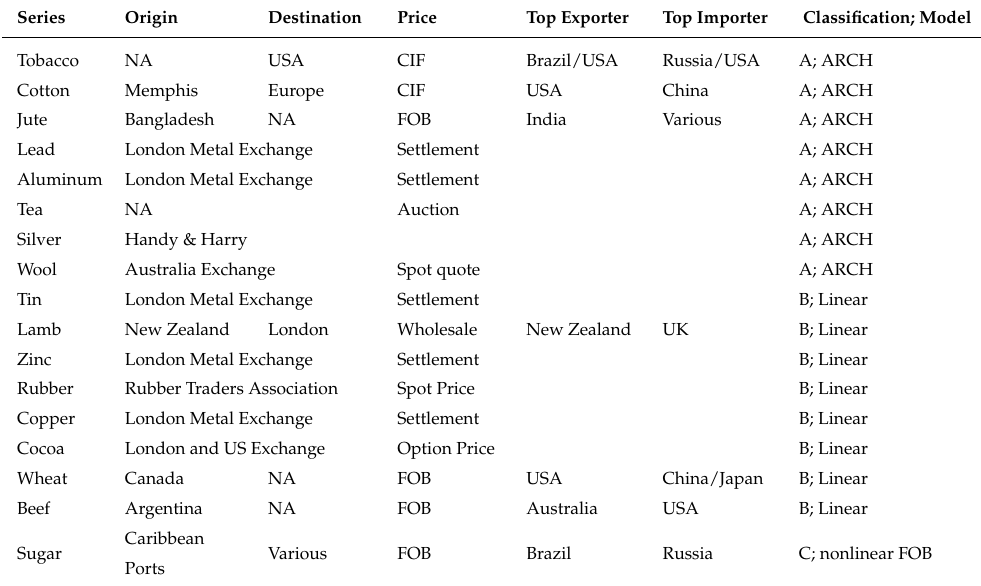
Table 1. Trading route, border price, top importer and exporter, and Fahmy’s (2011, 2017) work suggested classification for each individual commodity in the Grilli and Yang data